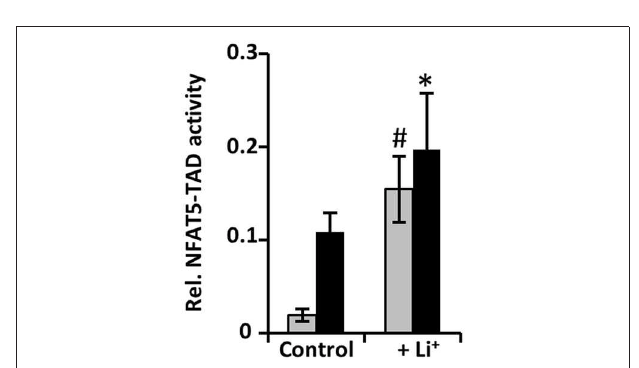
FIGURE 3 | Short-term exposure to lithium stimulates the transactivation domain of NFAT5. HEK 293 cells were electroporated with pGAL4-TonEBP-TAD and pFR-SEAP as described in Methods. Subsequently, cells were incubated for 24h in isosmotic ( ; 300 mosm/kg H 2 O) or hyperosmotic ( (cid:4) ; 500 mosm/kg H 2 O) medium and exposed to 10mM Li 2 SO 4 or 10mM Na 2 SO 4 (as control). Thereafter, SEAP activity was determined as described in Methods. Data are means ± SEM for n = 6 ; * P < 0.05 vs. hyperosmotic control; # P < 0.05 vs. isosmotic